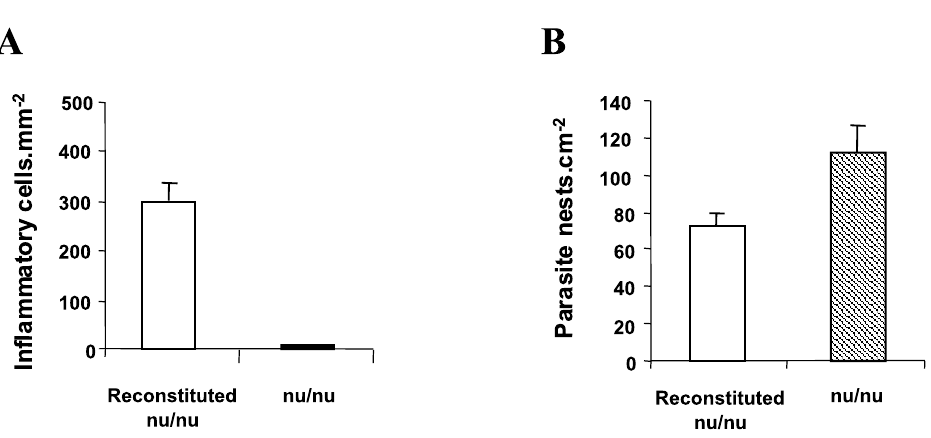
Fig. 1 – Degree of parasitism and number of inflammatory cells in hearts of T. cruzi -infected nu/nu mice. Normal BALB/c nu/nu mice or reconstituted with splenocytes were infected with 100 Colombian strain T. cruzi . Each column represents the mean number of inflammatory cells per mm 2 ( A ) or the mean number of parasite nests per cm 2 ( B ) in heart sections from three mice. Vertical bars represent the standard deviations of the